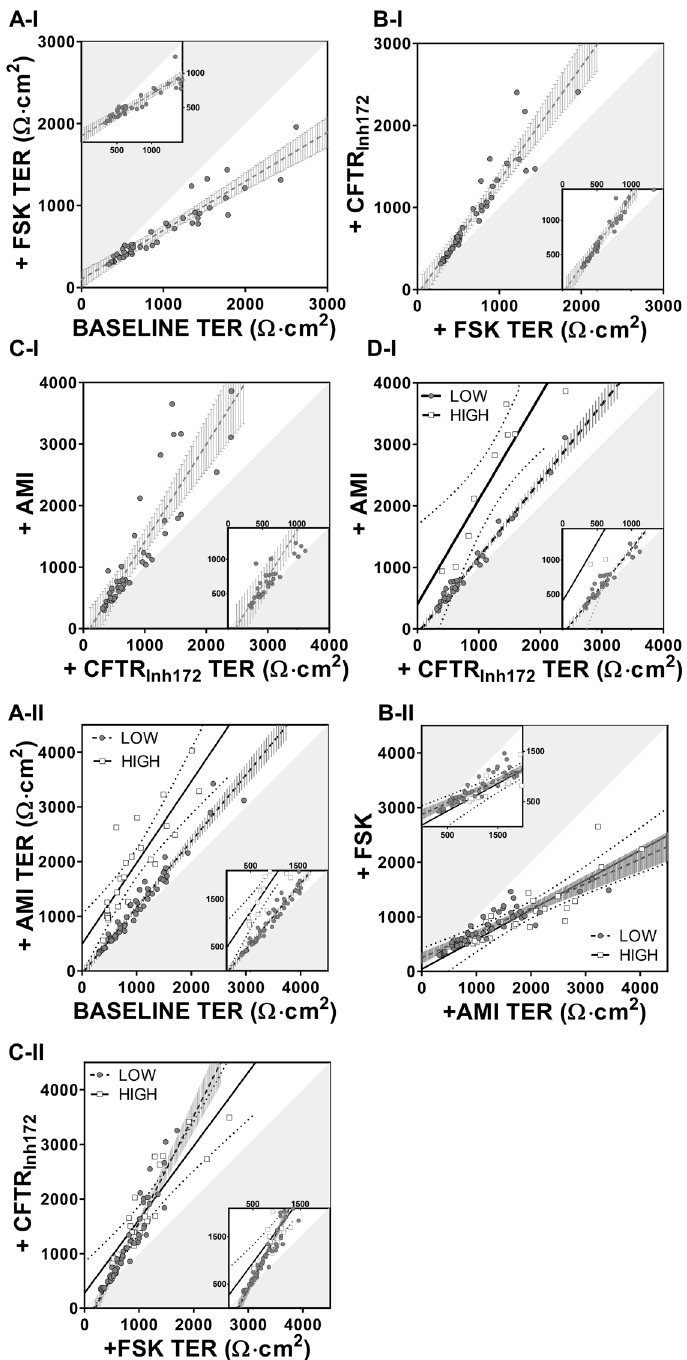
Fig 6. Drug induced effect on TER with respect to the rolling baseline. TER values at each stage of the drug regime chronologically are considered as baseline. The hypotenuse of the shaded triangular area represents the line of identity while magnification is shown in the box inserts. (A-I) The initial baseline TER values (closed grey circles) are plotted against the values obtained after addition of forskolin (n = 44). (B-I) TER values +FSK are plotted against values after addition of CFTR Inh172 (n = 44). (C-I) Values of TER with CFTR Inh172 plotted against values +AMI (n = 44); line of regression: dashed line +99% CI (grey vertical bars). In D-I same data as in C-I showing two distinct populations of amiloride responders designated as LOW (closed grey circles-black dashed regression line +99% CI vertical bars, n = 35) and HIGH (open squares, black regression line +99% CI dotted line, n = 9). (A-II) The initial baseline TER values are plotted against